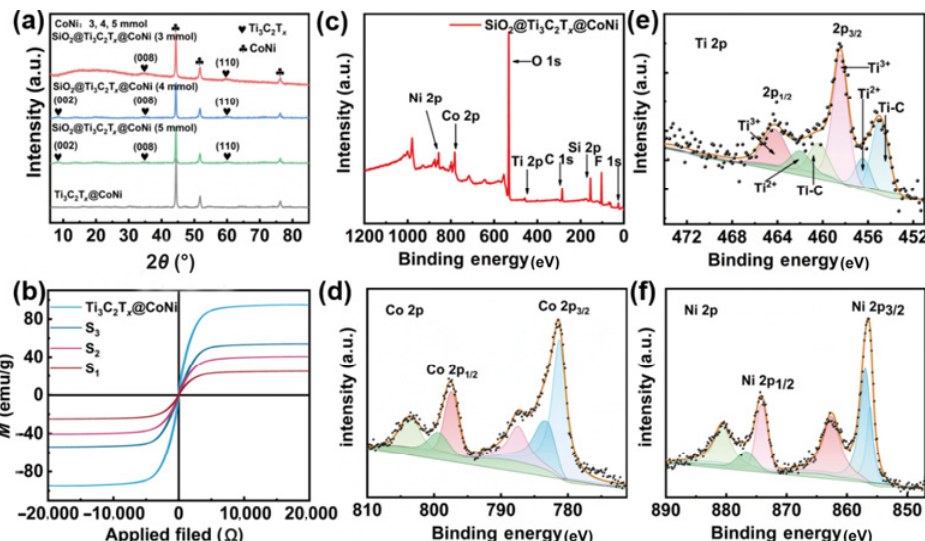
Fig. 2 (a) XRD patterns of 2D Ti 3 C 2 T x @CoNi nanosheets and SiO 2 @Ti 3 C 2 T x @CoNi microspheres, (b) magnetic hysteresis loops of SiO 2 @Ti 3 C 2 T x @CoNi microspheres and 2D Ti 3 C 2 T x @CoNi nanosheets ( M represents the saturation magnetization), (c)